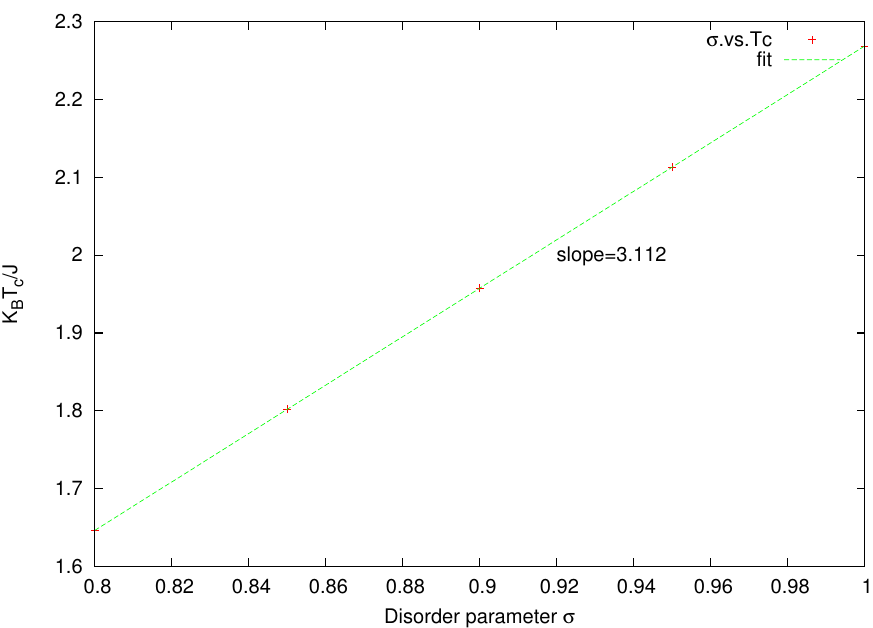
Fig. 4. The variation of the critical temperature relative to the disorder parameter σ